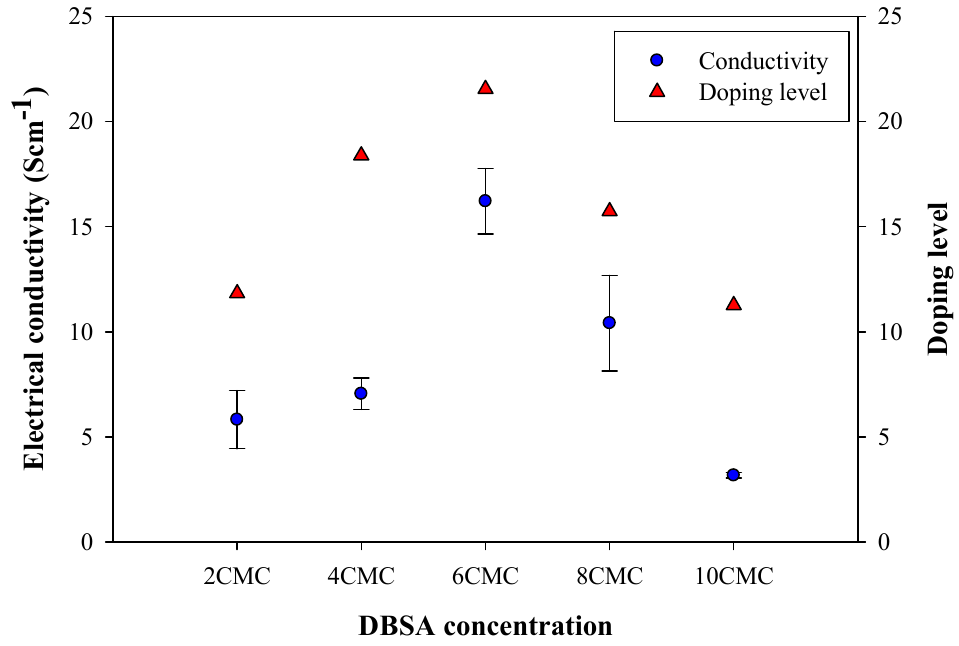
Figure 9. The relationship between the electrical conductivity and the doping level of P3HT at various surfactant concentrations.